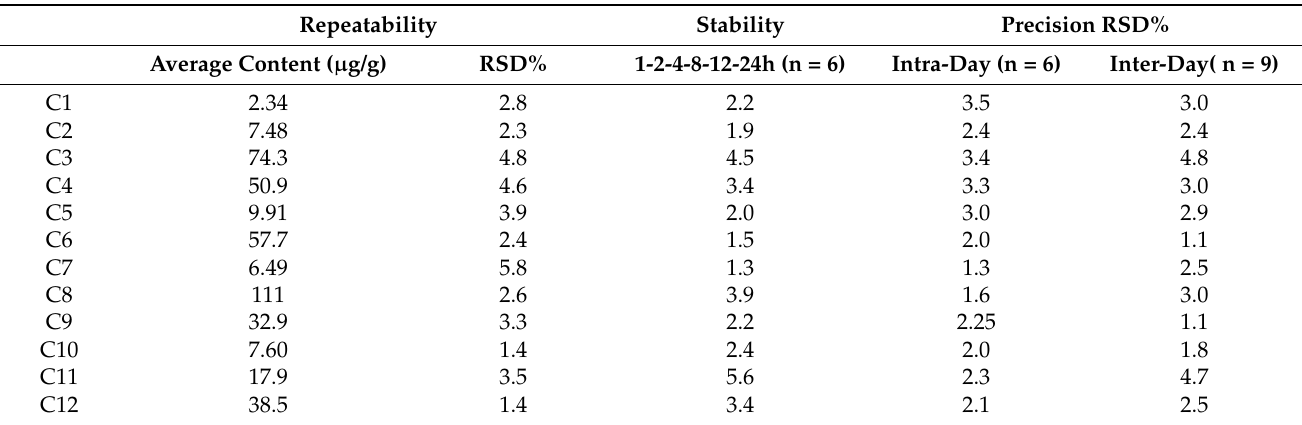
Table 2. Stability, repeatability, and precision of analysis of 12